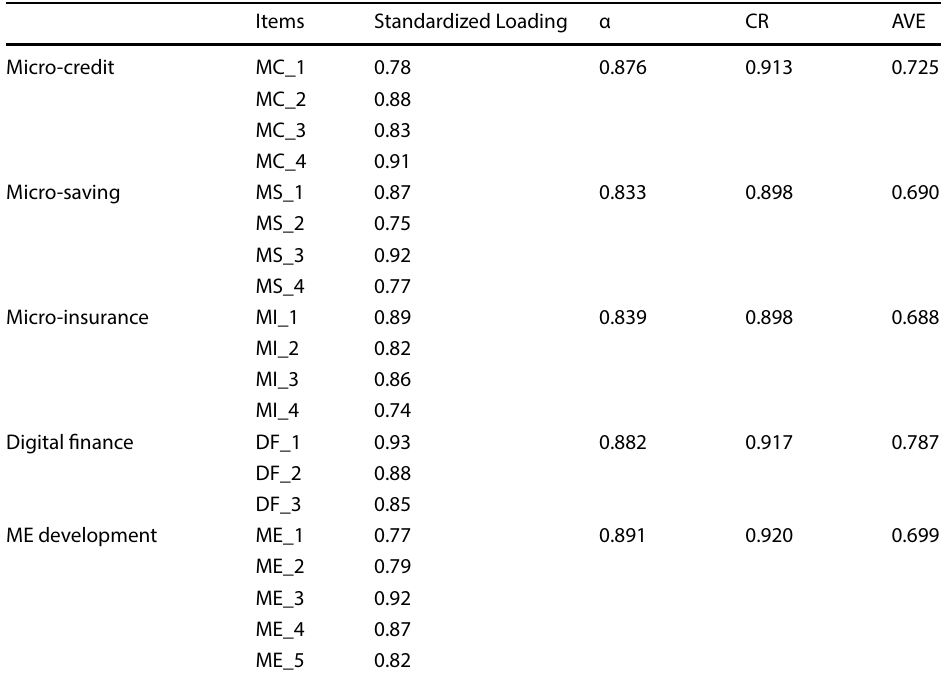
Table 5 Measurement model evaluation